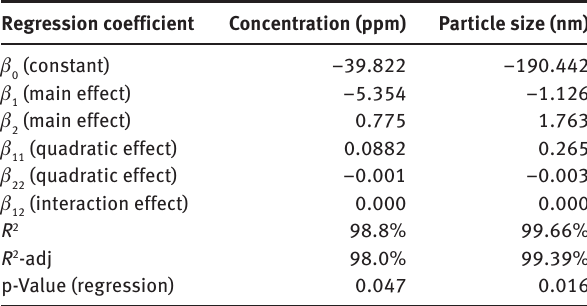
Table 2: Regression coefficients, R 2 , R 2 -adj, and probability values for the fitted models.